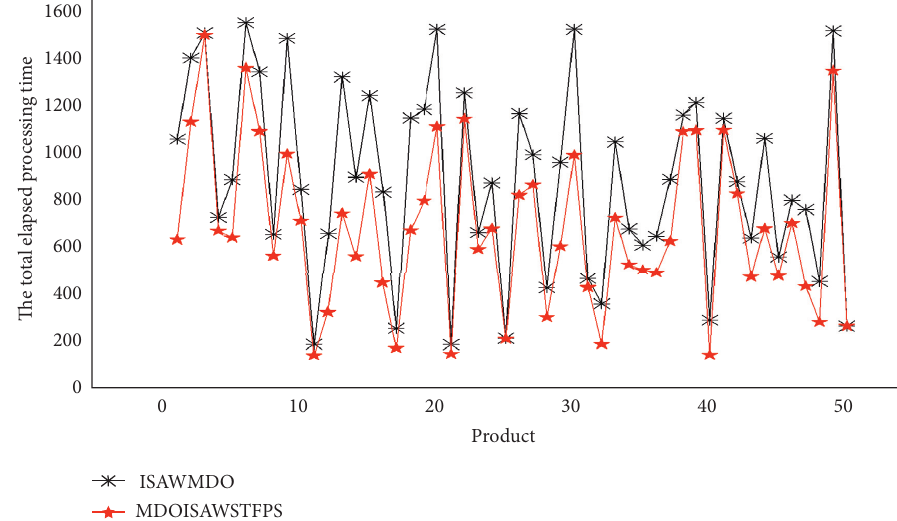
Figure 11: Comparison of the total elapsed processing time when the number of multiequipments is 3 for the two algorithms.